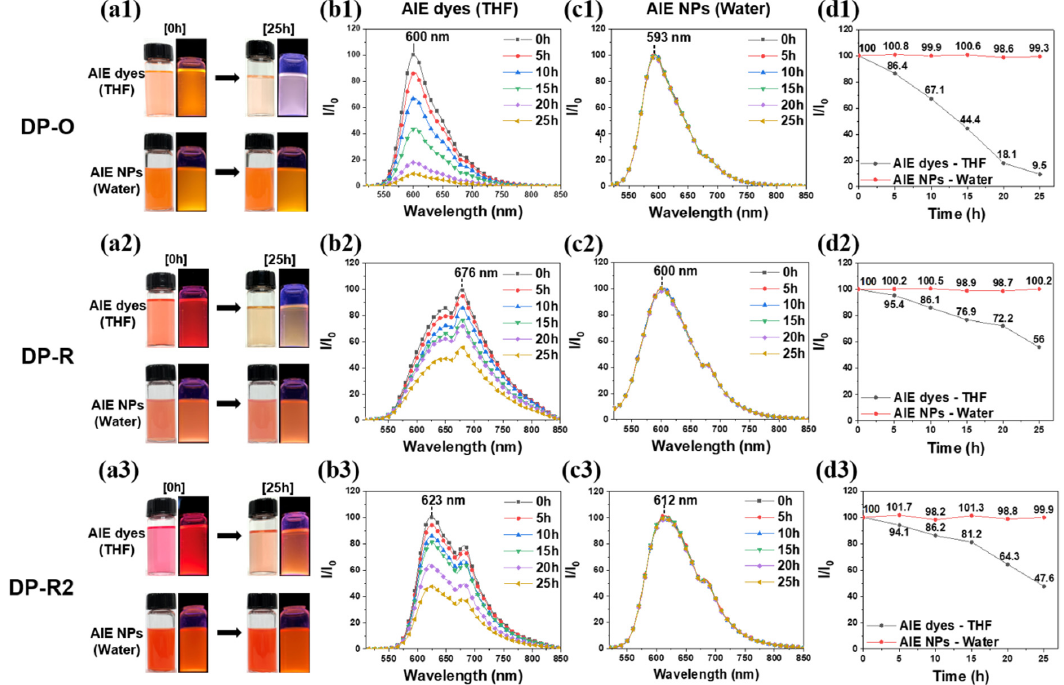
Figure 9. Fluorescence stability of DPP ‐ based AIE dyes and AIE NPs solutions. ( a1 – a3 ) photographs of fluorescence intensity at 0 and 25 h, ( b1 – b3 ) PL spectra of AIE dyes over time, ( c1 – c3 ) PL spectra of AIE NPs over time, and ( d1 – d3 ) Comparison of PL intensity of AIE dyes and AIE NPs. (Excitation wavelength = 365 nm).